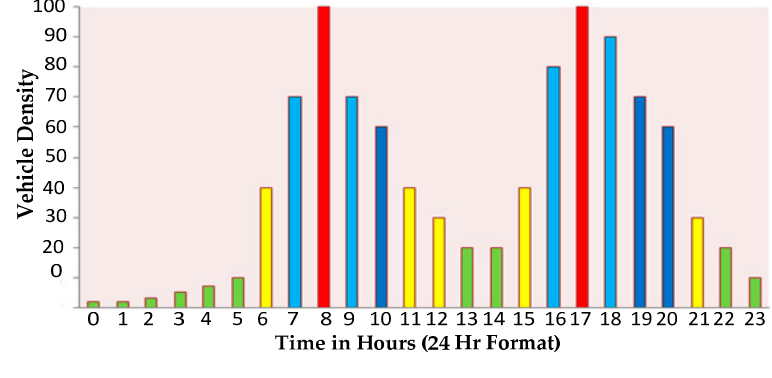
Figure 4. Urban traffic density.